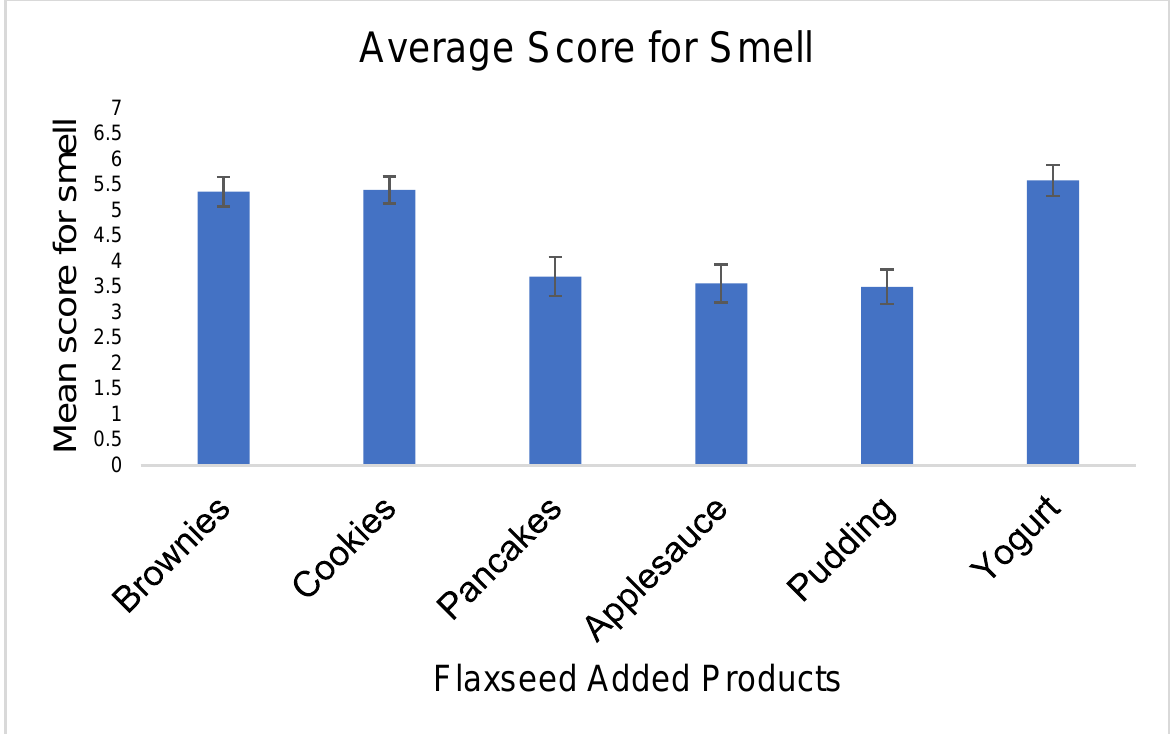
Figure 2. Bar chart of the mean score with SEM for smell for all flaxseed products.